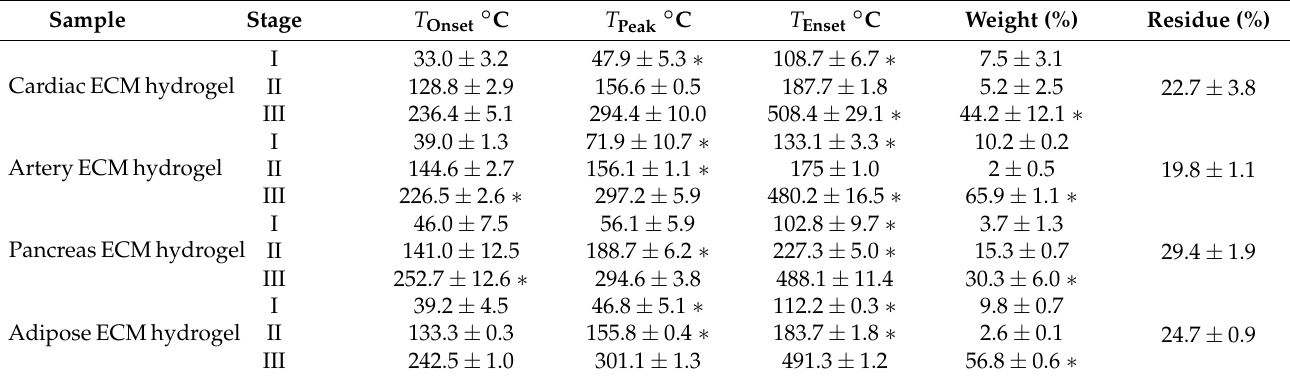
Figure 2. Preservation of the pECM hydrogels composition. Thermal gravimetric analysis of pECM hydrogels and decellularized pECM. TG 1st derivative curve of cardiac, artery, pancreas, and adipose pECM. Table 2. Thermal gravimetric analysis summary of the degradation steps.